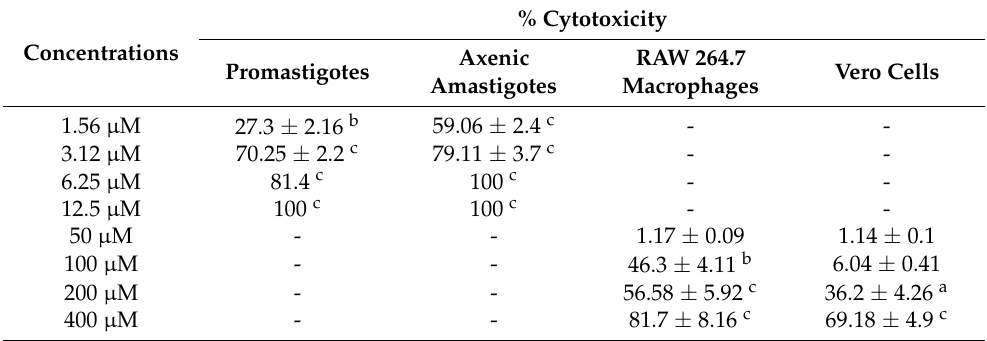
Table 1. Cytotoxic effects of β -ocimene on Leishmania (Leishmania) amazonensis promastigotes and axenic amastigotes, and RAW 264.7 macrophages. Data represent the average cytotoxicity percentage (%) ± standard error for three independent experiments performed in duplicate, considering the control group as 0% cytotoxicity; ( a ) p < 0.05 vs. control; ( b ) p < 0.01 vs. control; ( c ) p < 0.001 vs. control.